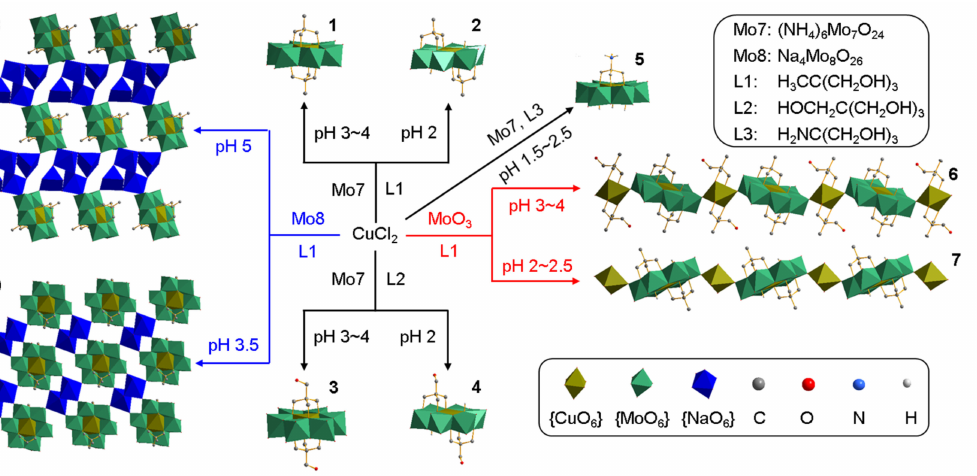
Scheme 1. Schematic illustration for the synthetic parameters in different decoration fashions and extended structures in the preparation of Cu-centered Anderson–Evans POMs 1 – 9 . All H atoms except those attaching to N and µ 3 -O atoms are omitted for clarity. The bold numbers are added to represent the corresponding